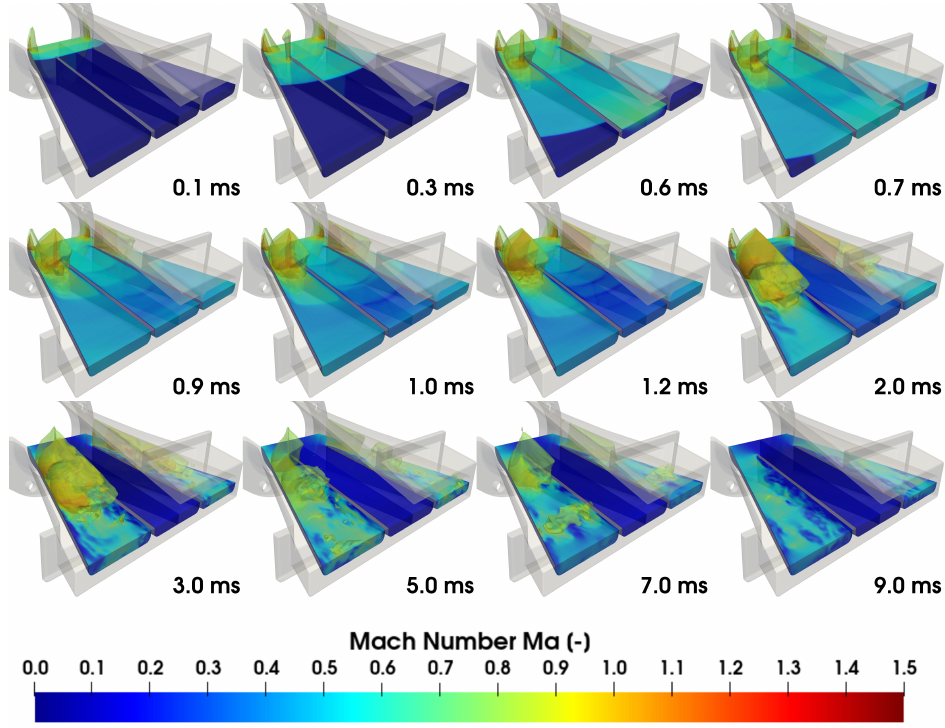
Figure 17. Snapshots of Mach number contour plots for 12 time frames.